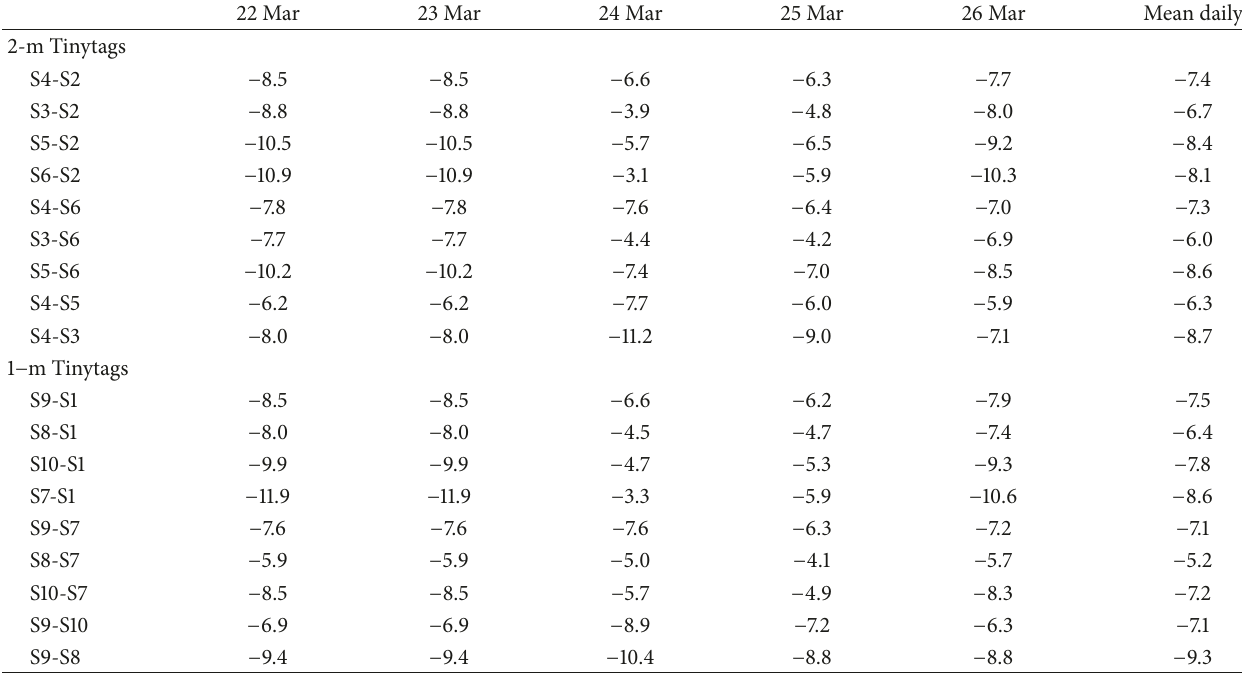
Table 7: Daily and mean daily lapse rates ( ∘ C km −1 ) between various pairs of Tinytag sensors based on 1-min